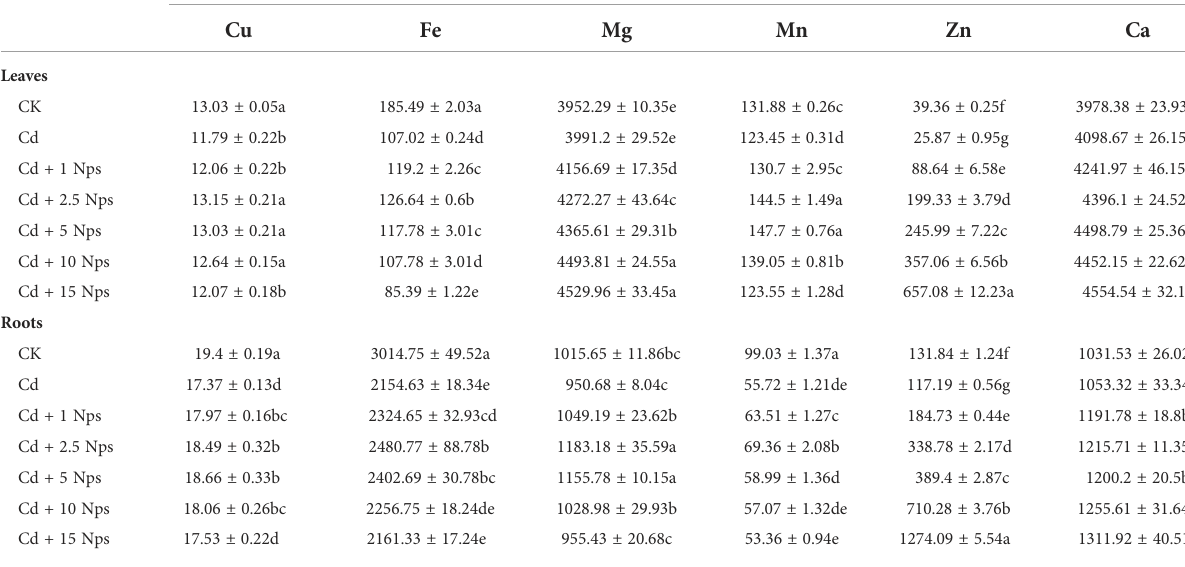
TABLE 1 Effects of ZnONPs on nutrient elements uptake by lettuce under Cd stress. Treatment